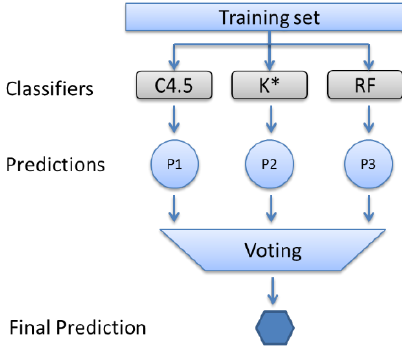
Figure 7. The Proposed ensemble classifier.